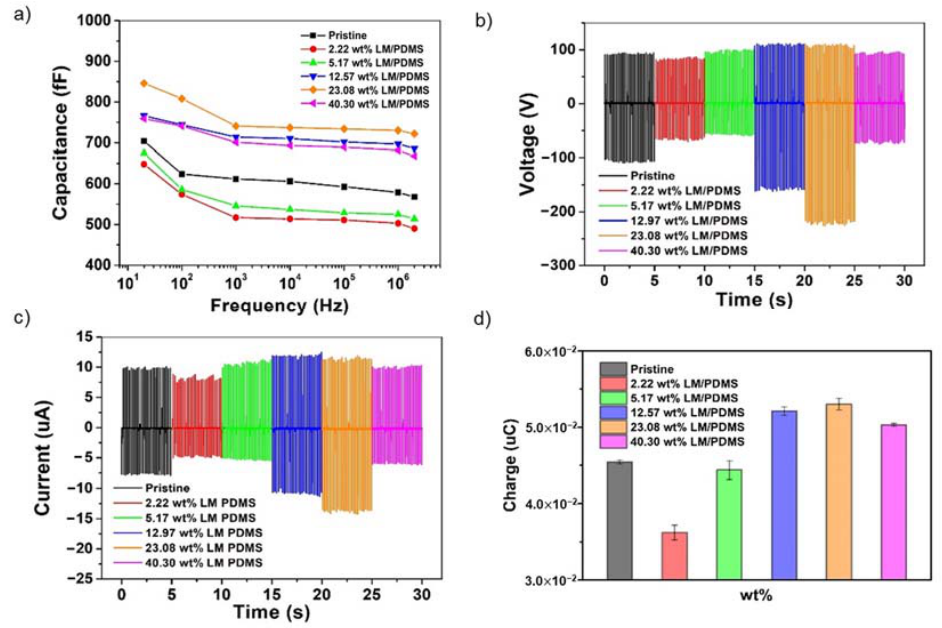
Figure 4. ( a ) Characteristic curves displaying capacitance variation as a function of frequency for di ff erent weight percentages. ( b ) Open-circuit voltage measurements obtained from TENGs constructed with LM/PDMS films of varying weight percentages. ( c ) Short-circuit current measurements obtained from TENGs constructed with LM/PDMS films of varying weight percentages. ( d ) The charge amount Q obtained from TENGs constructed with LM/PDMS films of varying weight percentages.